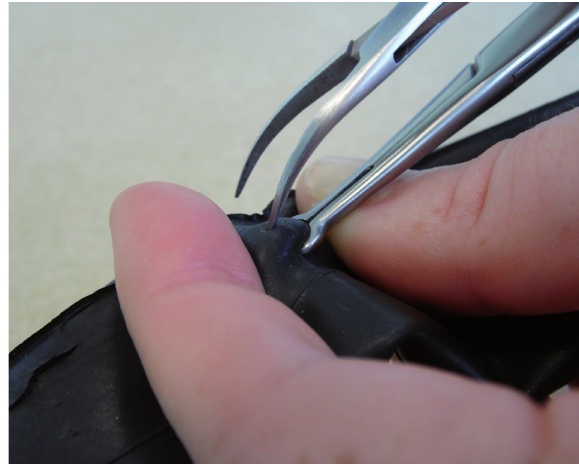
Figure 5 - Piercing the skin, fascia and vas with a single tine.